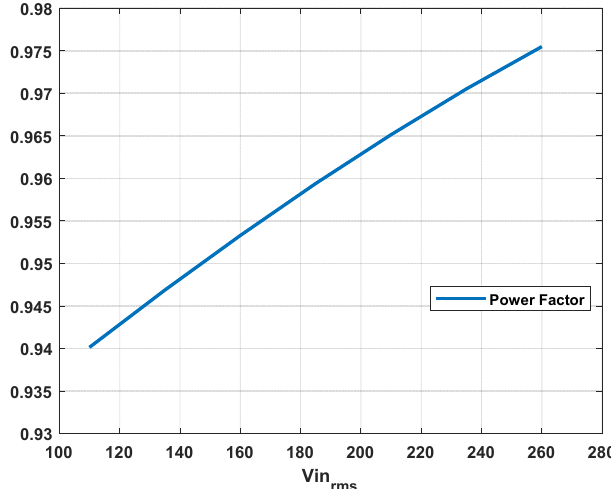
Figure 16. Power factor of the line input current over the universal voltage range.